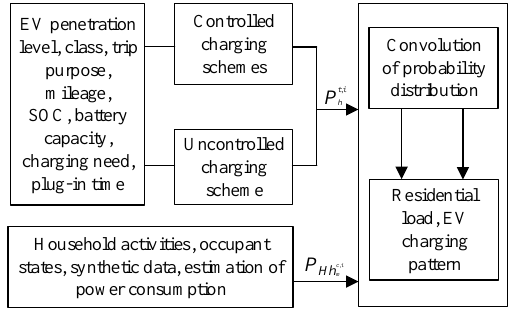
Figure 1. Flow diagram of the adopted